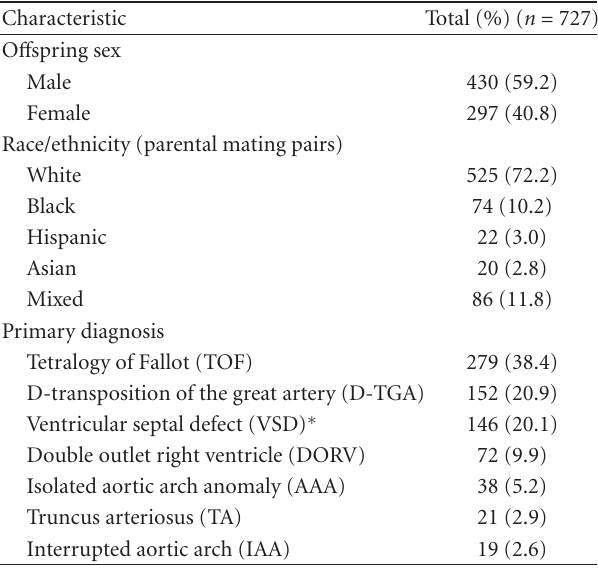
Table 1: Characteristics of study cases and parents, Children’s Hospital of Philadelphia,